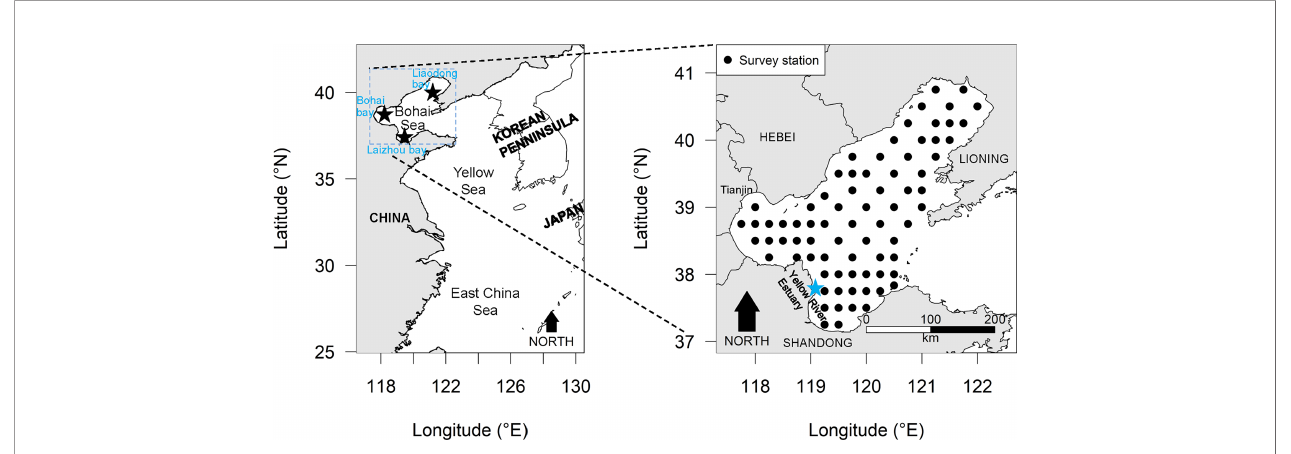
FIGURE 1 | The locations of the Bohai Sea sampling stations where the small yellow croaker ( Larimichthys polyactis ) data utilized in the present study were